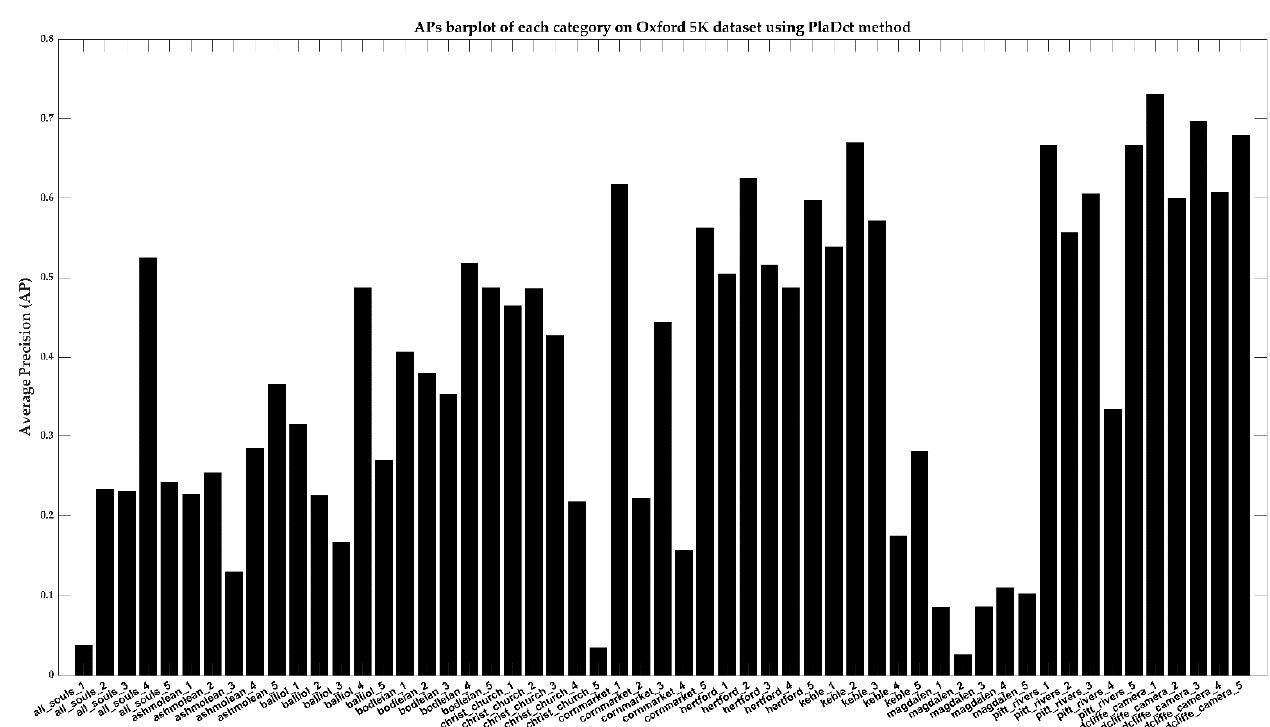
Figure 18. APs bar plot of each query on the Oxford building dataset using the PlaDct method.